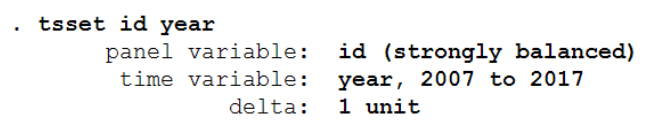
Figure 1. The process of defining a spatial and a temporal